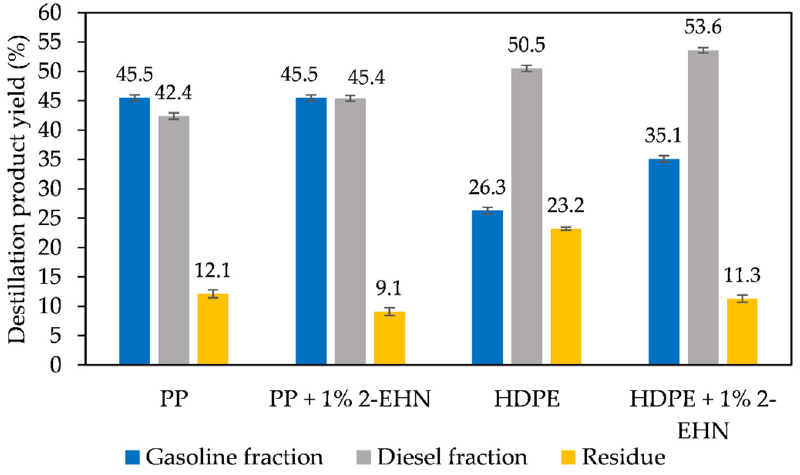
Figure 10. Atmospheric distillation of pyrolysis oils (Gasoline fraction—blue, Diesel fraction—grey,